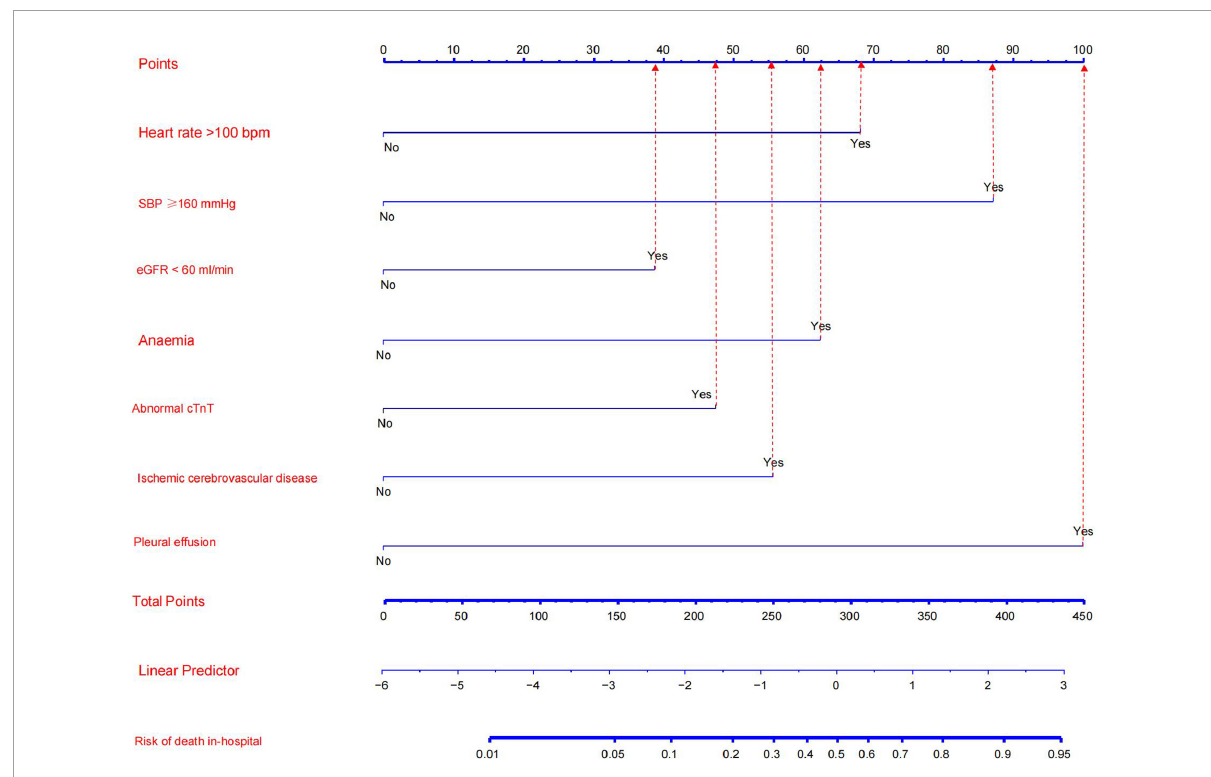
FIGURE3 Nomogram model for predicting the risk of in-hospital death in patients with Stanford type B aortic dissection. Every factor in the nomogram got an individual score according to the value of factor, and a total score was obtained by summarizing the scores of the seven factors, which could be used to estimate the probability of the risk of in-hospital death in this type B aortic dissection